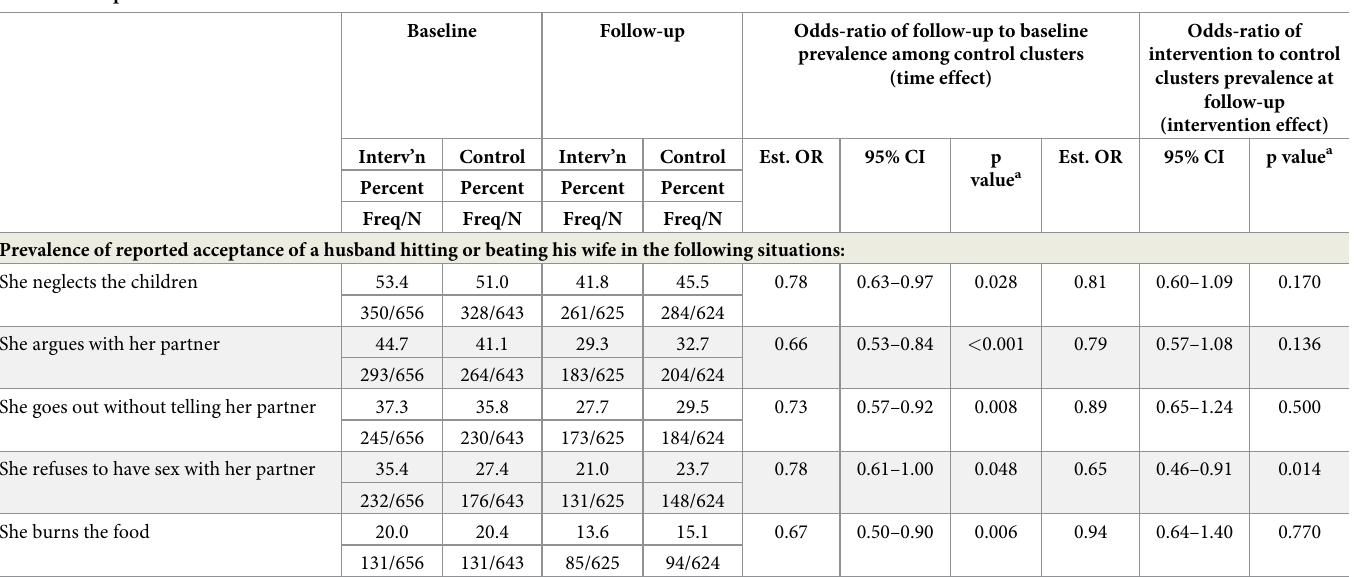
Table 6. Acceptance of IPV.